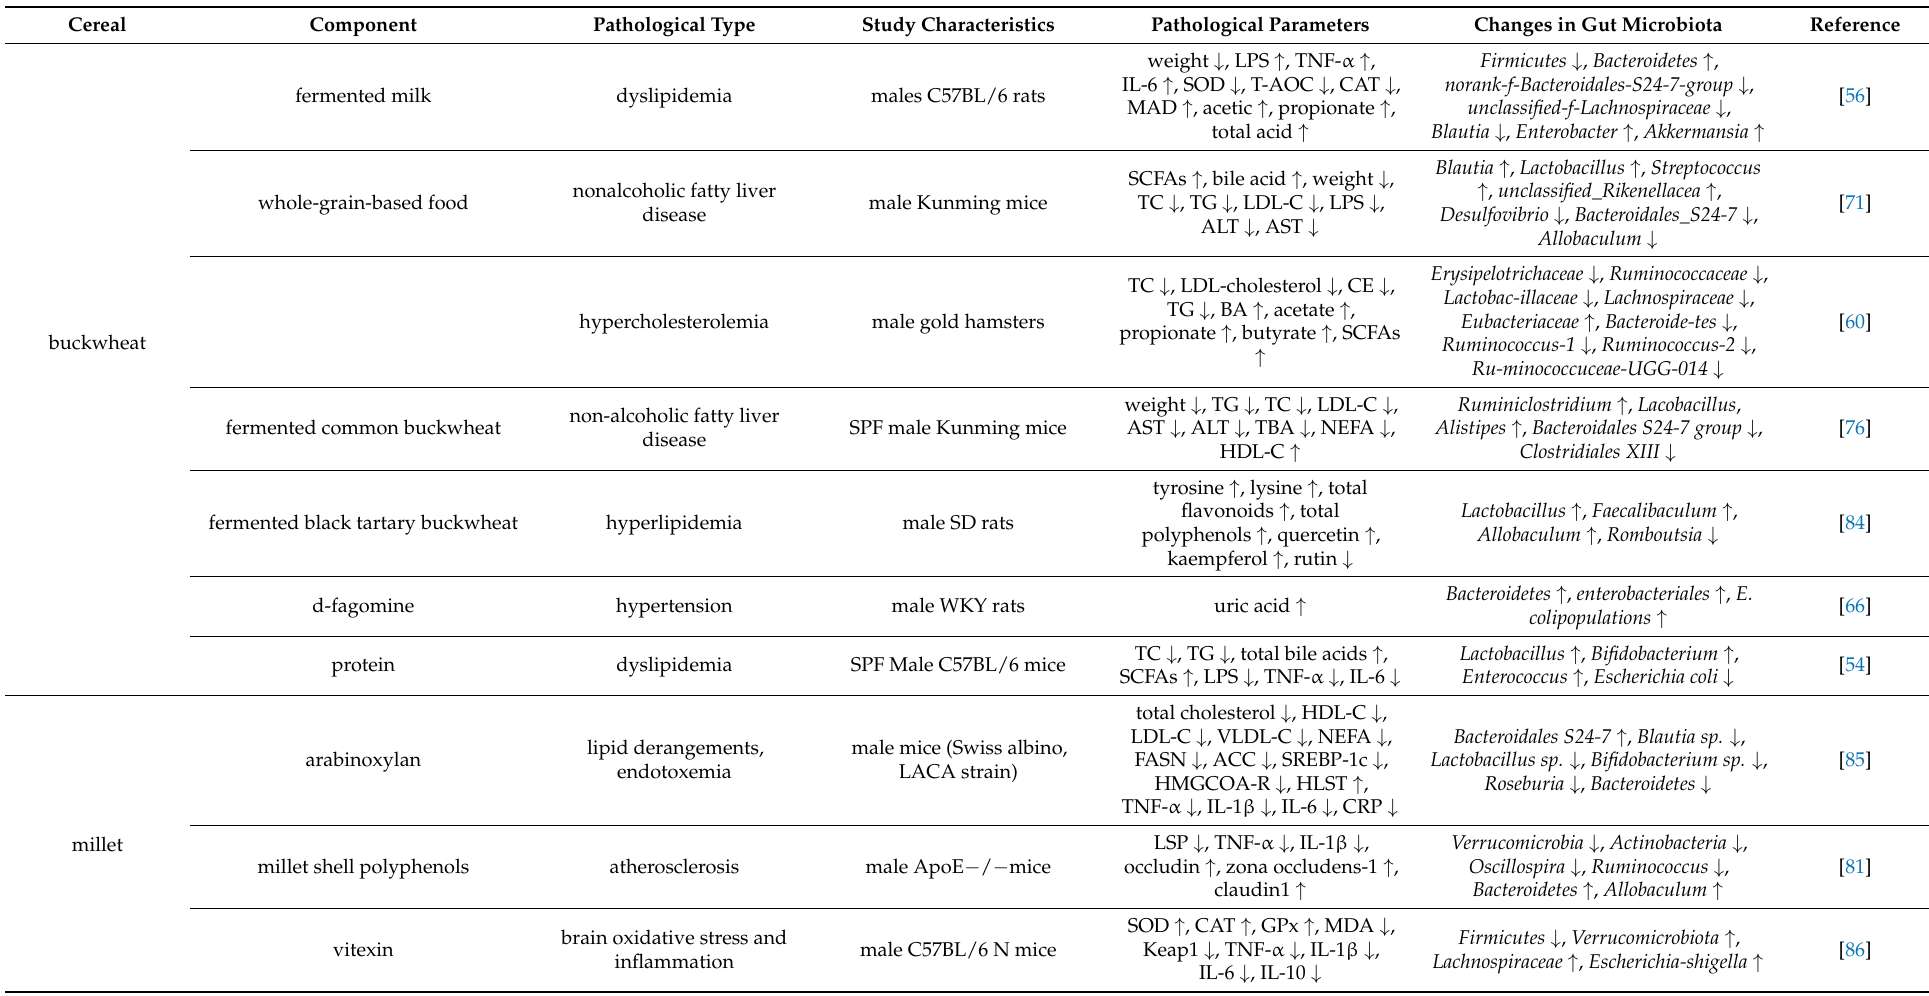
Table 2. Effect of whole-grain components on gut microbiota of cardiovascular diseases